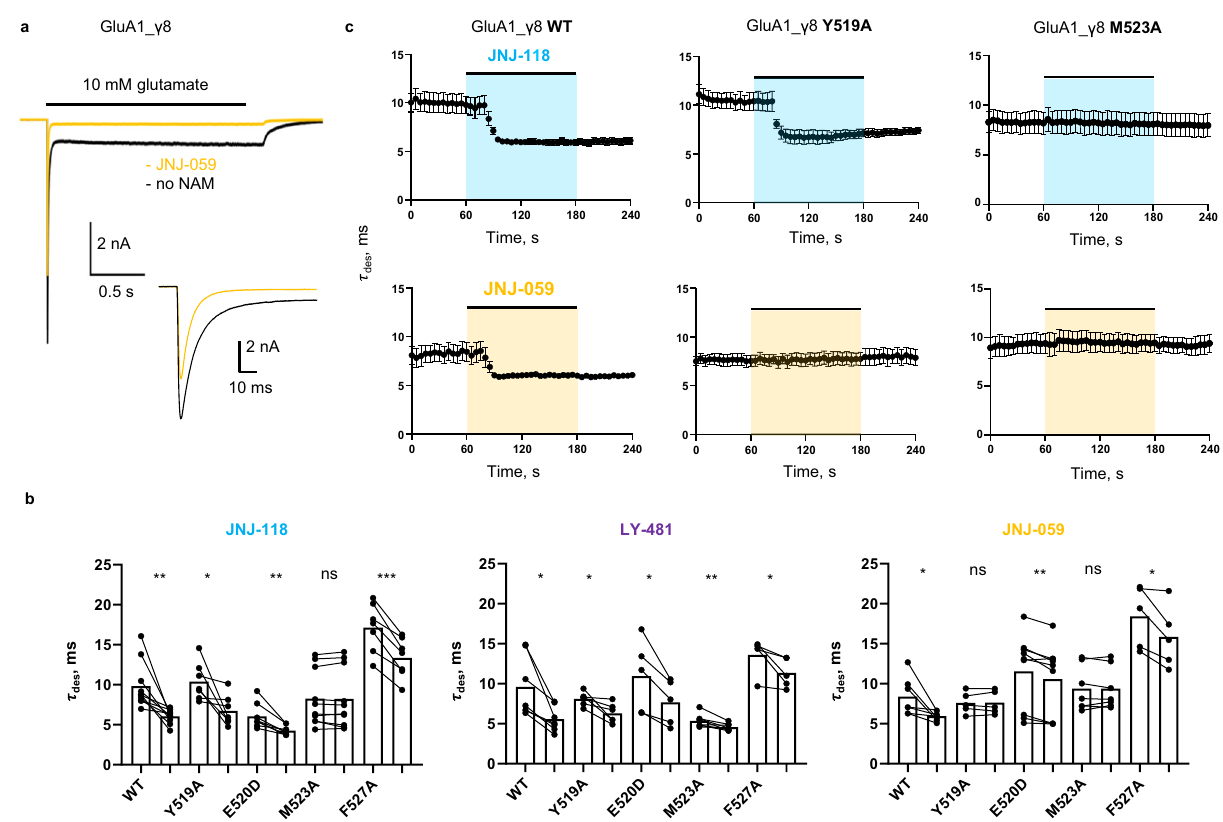
Fig. 4 | Functional NAMeffectsonwildtype and mutant GluA1_ γ 8.a Whole-cell response of GluA1_ γ 8 to 10mM glutamate (2s; -60 mV), in either the absence (black) or presence (yellow) of JNJ-059. The inset zooms into the peak response. b Paired bar plots showing effect of 10 µ M JNJ-118, LY-481 or JNJ-059 on desensiti- zationtimeconstantforwildtypeormutatedGluA1i_ γ 8.Eachpointisameasureof parameter in absence or presence of modulator. Bar height represents the mean value. Asterisks indicate summary of two-tailed paired t -test values: * p ≤ 0.05, ** p ≤ 0.01, *** p ≤ 0.001 and ‘ ns ’ for p >0.05. Number of cells: JNJ-118: n =10,7, 8, 10, and 7; LY-481: n =7, 6, 5,8, and 5; JNJ-059: n =7, 5, 9, 7, and 5 for wt, Y519A,E520D, using whole-cell recordings of GluA1 fused to γ 8 (denoted GluA1_ γ 8).